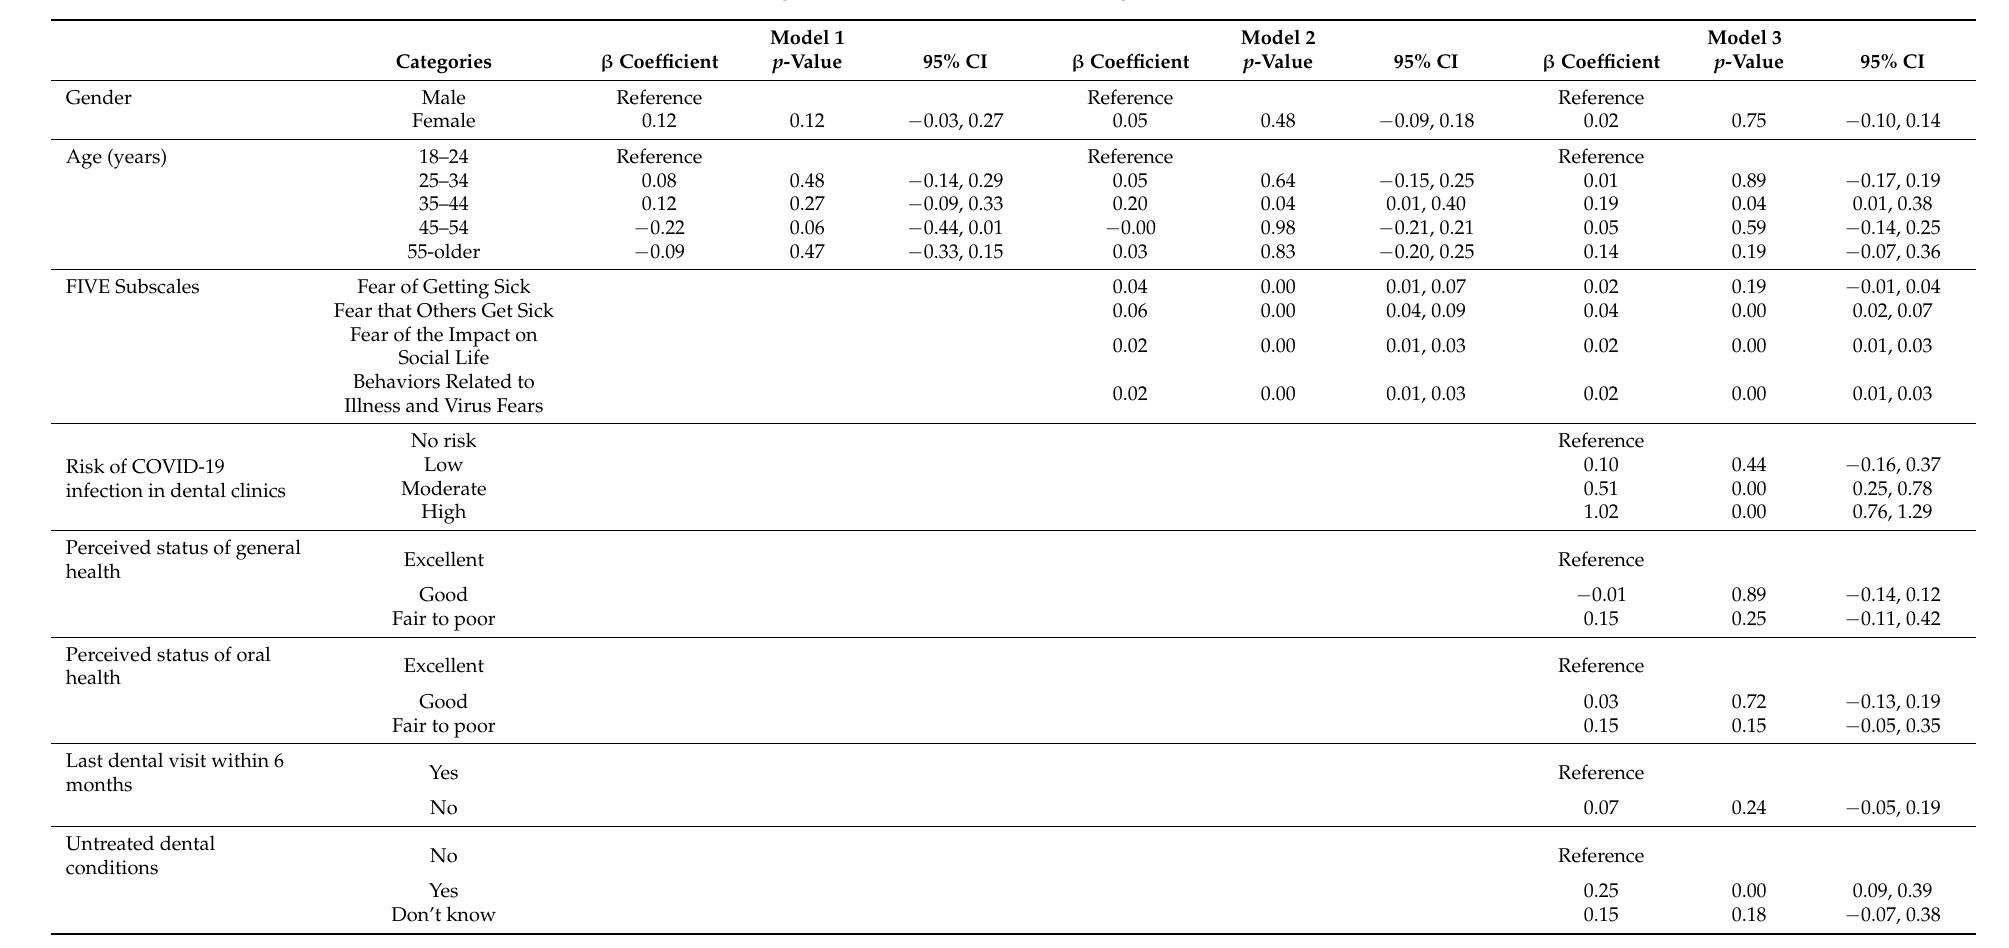
Table 3. Factors associated with higher fear to seek dental care during COVID-19 outbreak in Saudi Arabia (n=